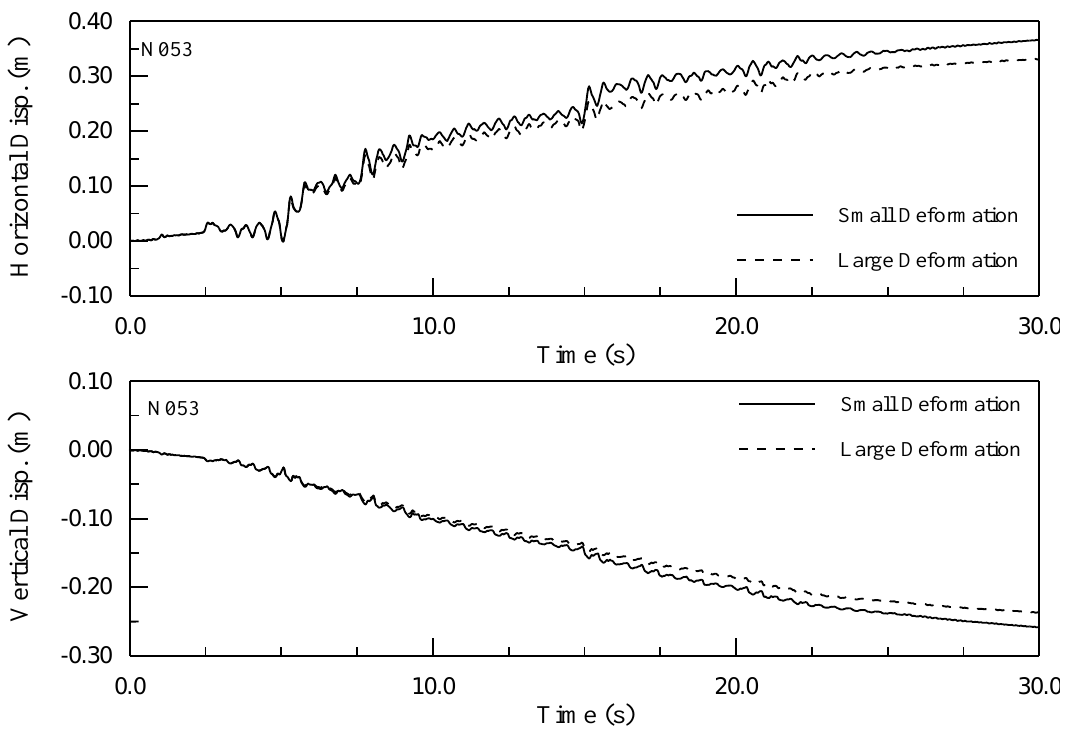
Figure 11. Horizontal and vertical displacement – time histories at node N053 — severe shaking.